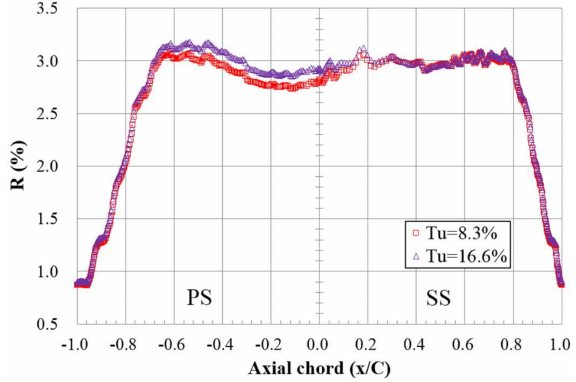
Figure 8. Effects of turbulence intensity ( Tu ) and TBC on surface temperature reduction ( R ) at midspan.